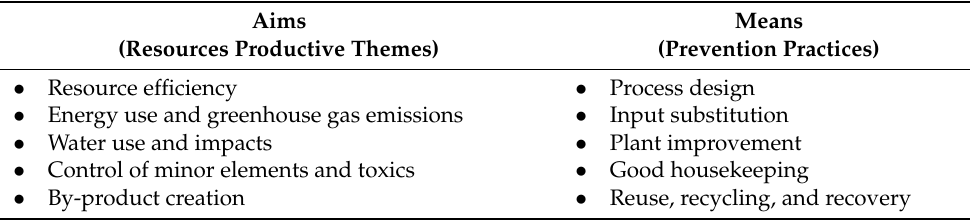
Table 4. Aims and means of eco-efficiency framework for mineral processing